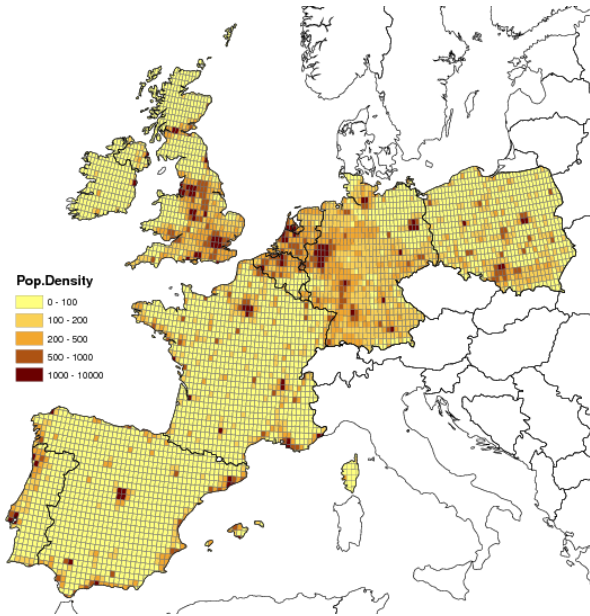
Fig. 1 : Population density on a 0.25°x0.25° grid (source: CIESIN, 2005) is used as a proxy for insured values in the regions for which loss calculations were performed (unit: inhabitants per km²).